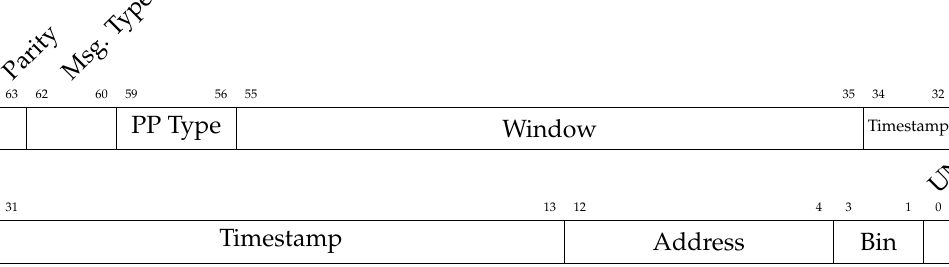
Figure 6. Dataframe of the the QKD output mode. UN [1 bit]: Unused. Bin [3 bits]: In which time-bin value the event is attributed to. Address [9 bits]: Address of the pixel. Timestamp [22 bits]: Relative timestamp to the end of the window in picoseconds. Window [21 bits]: Number of windows since last reset. PP Type [4 bits]: Post-processing type used. For example, “QKD Rel. Timestamp” or “QKD time-bin”. See Figure 2. Msg. Type [3 bits]: Message type. Indicates if it came from array the 8 × 8 or 1 × 14 array for example. Parity [1 bit]: Parity bit